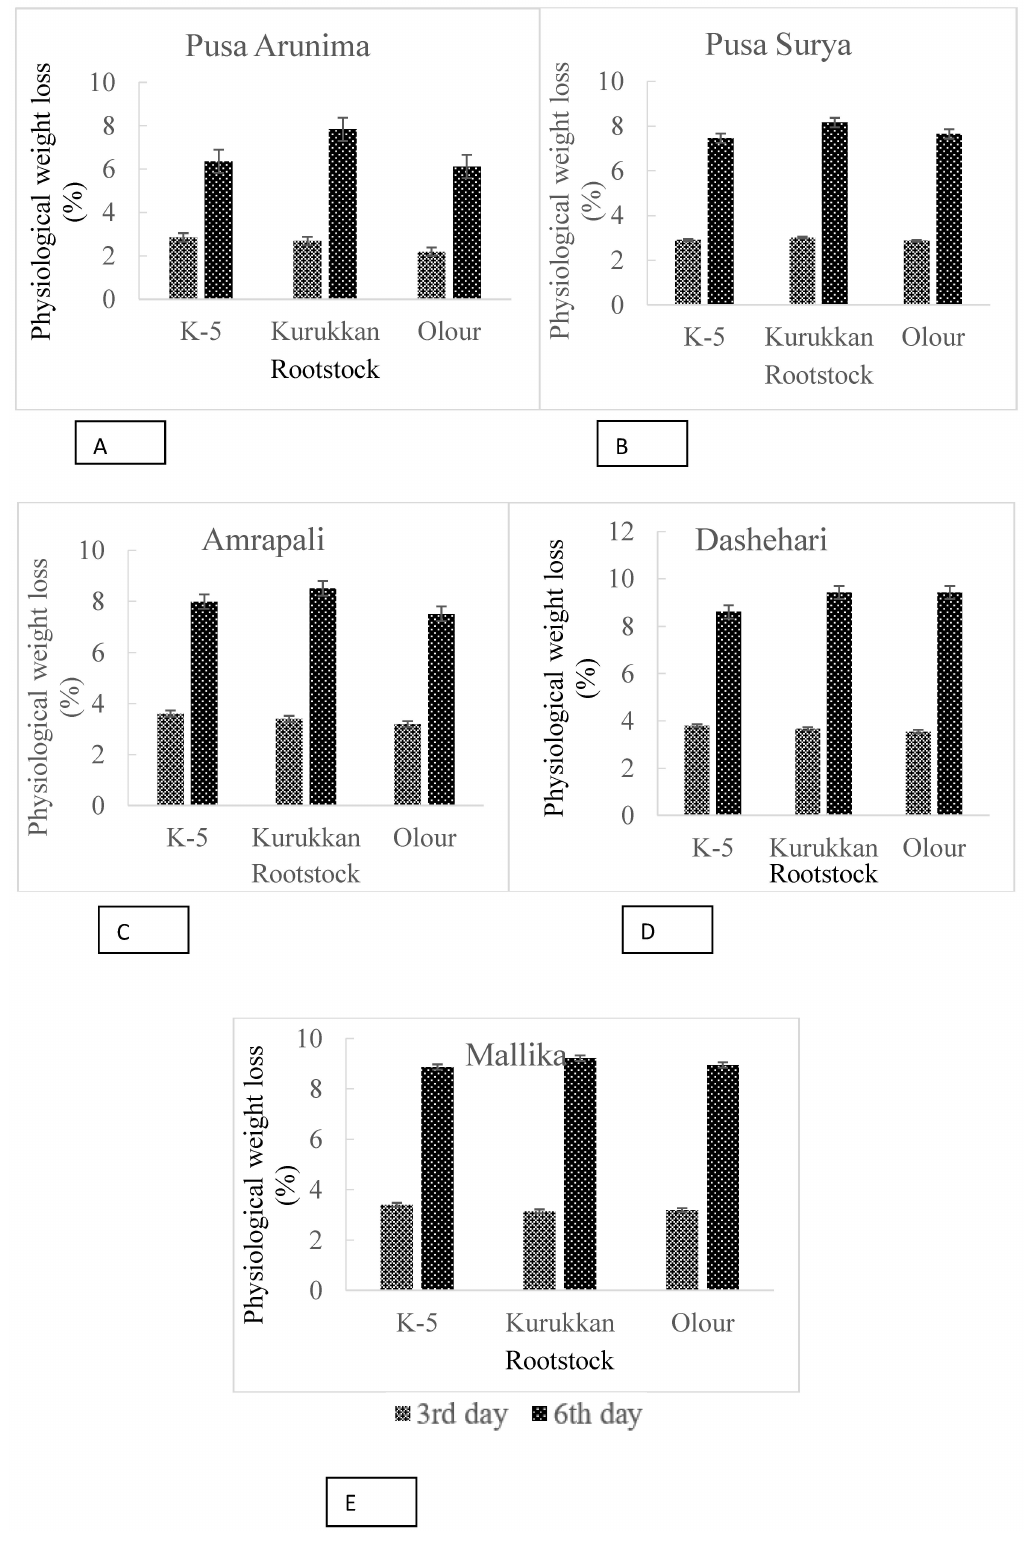
Figure 1. Physiological weight loss (PLW) at the 3rd and 6th days of storage as affected by scion/rootstock combinations in mango varieties: ( A ) Pusa Arunima, ( B ) Pusa Surya, ( C ) Amrapali, ( D ) Dashehari, ( E ) Mallika. Vertical bar indicates mean values of three samples ± standard error (SE). The LSD ( p ≤ 0.05) for the 3rd day storage: variety; 0.09, rootstock; 0.07, and variety × rootstock; 0.15, for 6th day storage, variety; 0.02, rootstock; 0.15, and variety × rootstock;